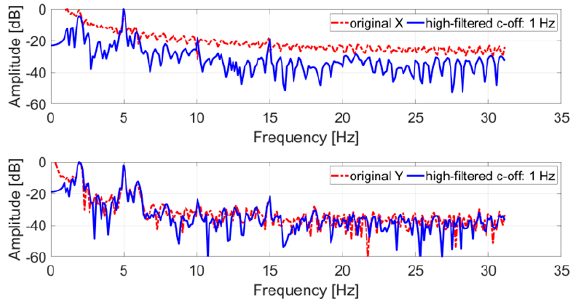
Figure 7. Frequency spectrum of an acquired SM test trajectory (x and y coordinates); in blue, the